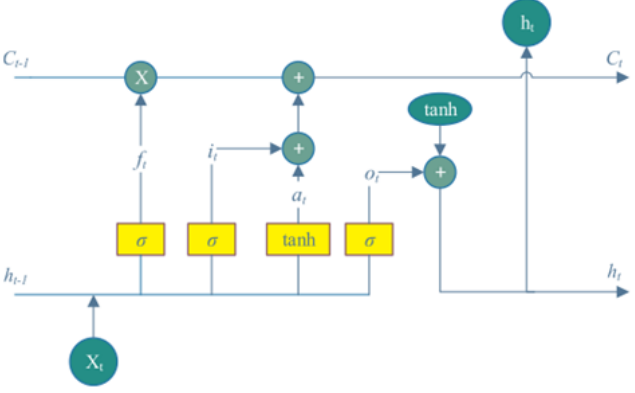
Figure 1. Detailed layout of a long short-term memory unit